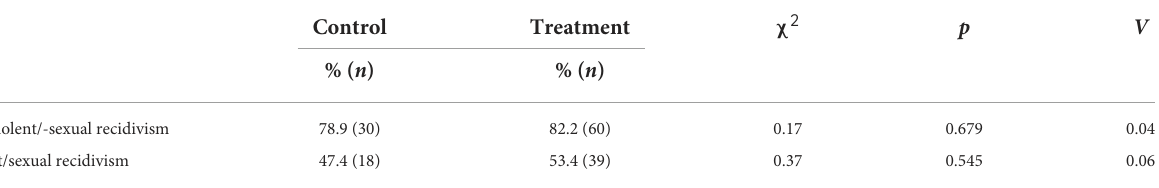
TABLE 3 Post-release recidivism in the control ( n = 38) and treatment group ( n =